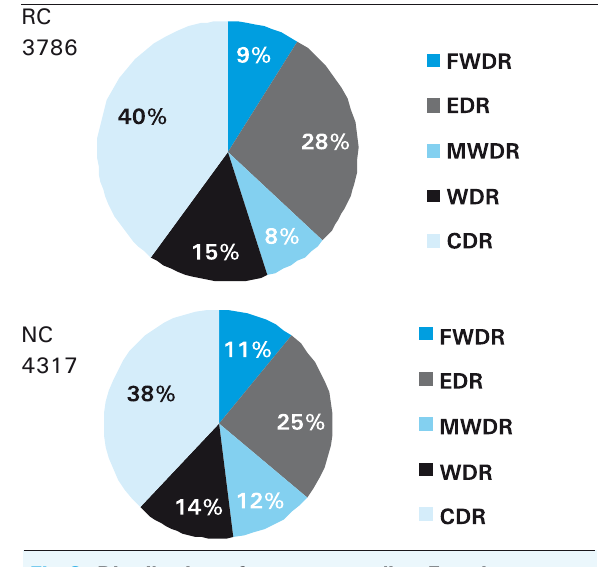
Fig 2. Distribution of cases according 5